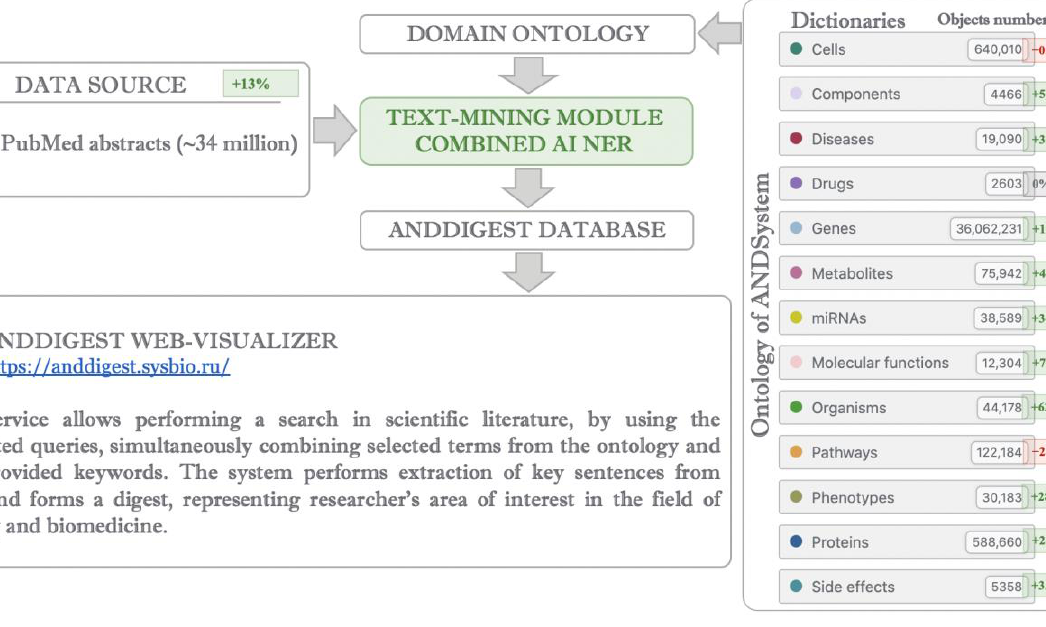
Figure 1. A schematic illustration of ANDDigest ver. 01.2022. Green and red colors highlight new modules and data changes compared to the previous version.